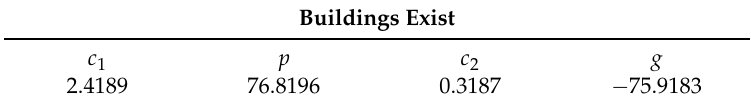
Table 9. The parameters of the gas diffusion model with the influence of